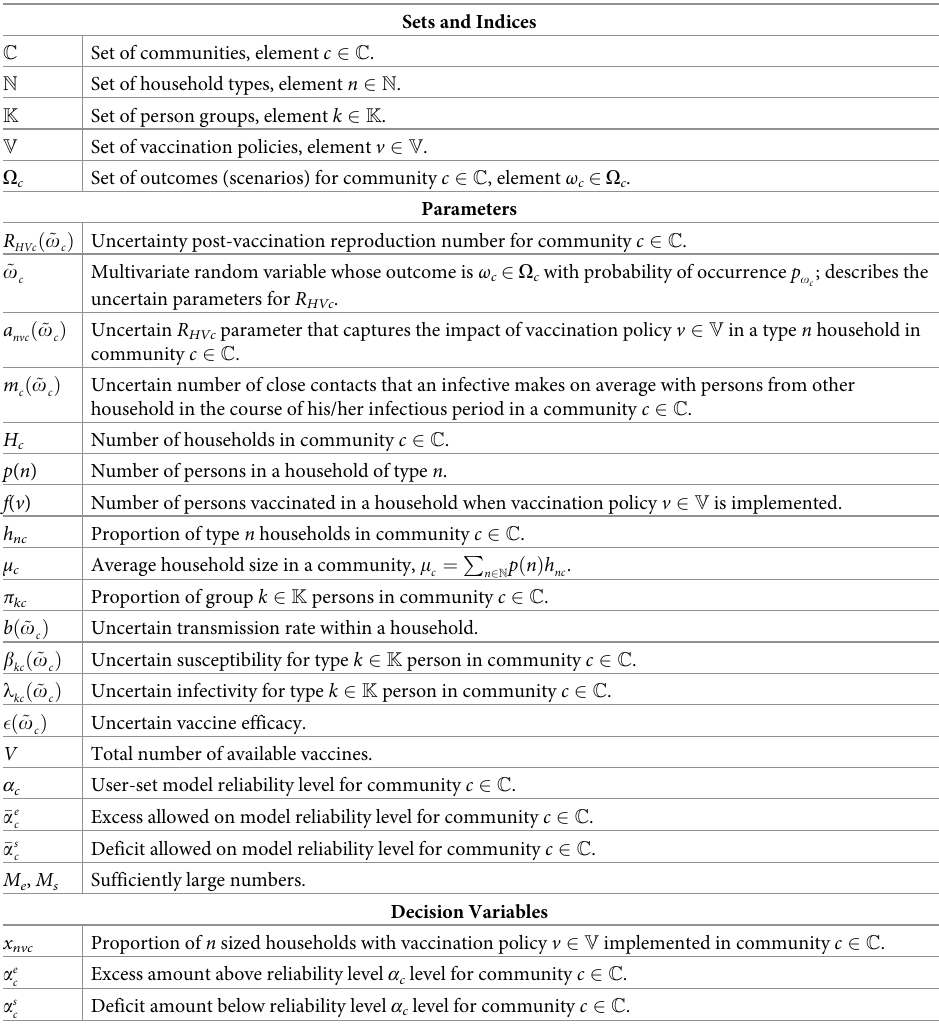
Table 1. Notation used in defining the models.